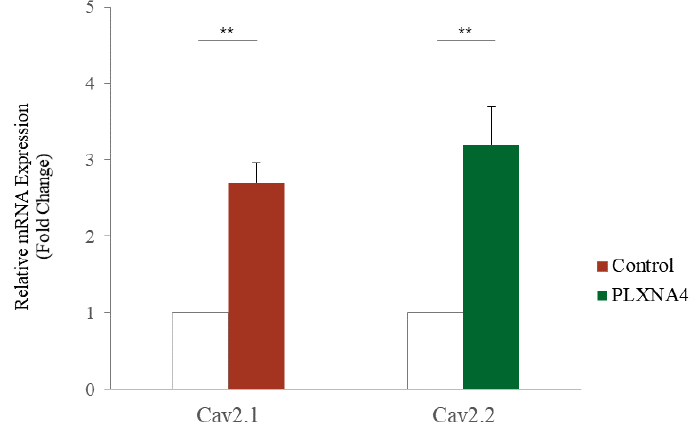
bars to standard deviations ( n = 3). * p < 0.05, ** p < 0.01.